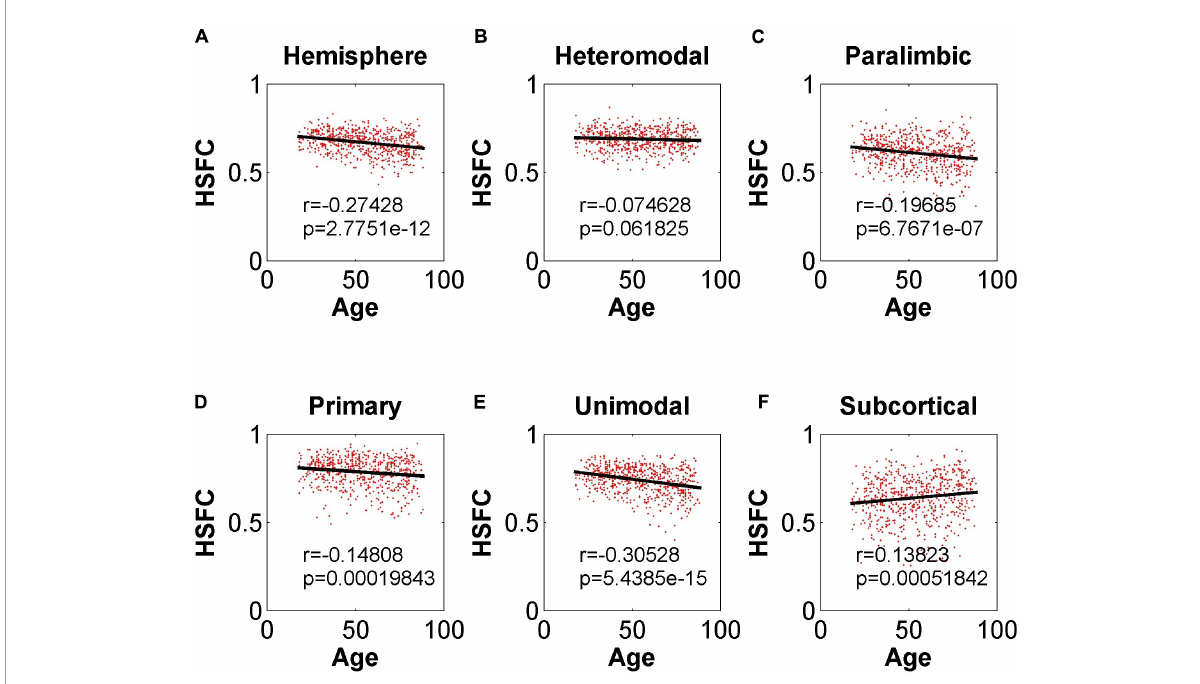
FIGURE4 Pearson correlation between age and HSFC of hemisphere and five sub-modules. (A–F) Represent the hemisphere, heteromodal, paralimbic, primary, unimodal, subcortical, respectively.